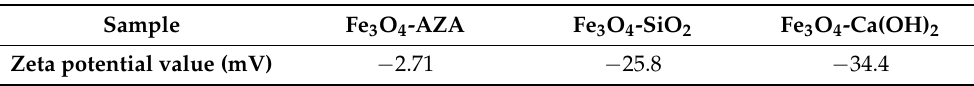
Table 2. Zeta potential values for Fe 3 O 4 -AZA, Fe 3 O 4 -SiO 2 and Fe 3 O 4 -Ca(OH) 2 in deionized suspension.